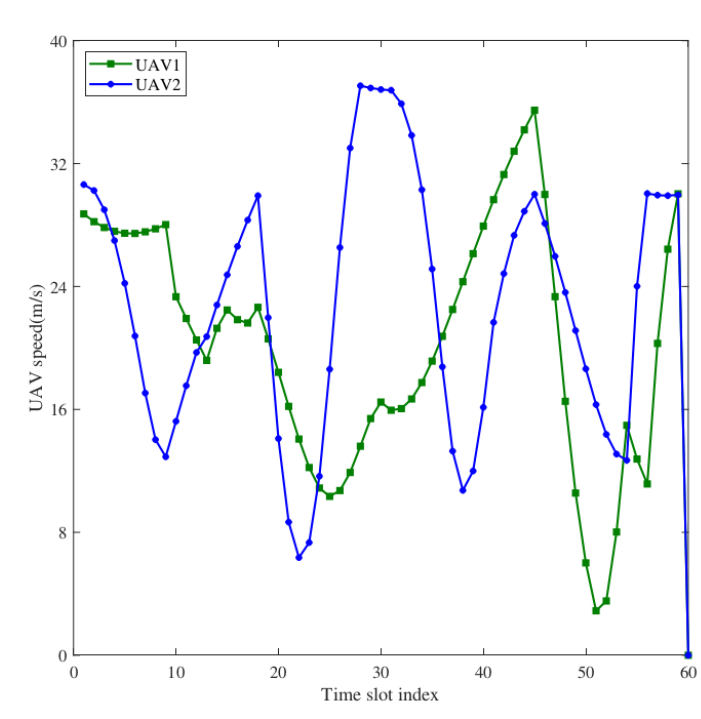
Figure 3. The UAV flight speed when the warden is located at [ 450,450 ] T .